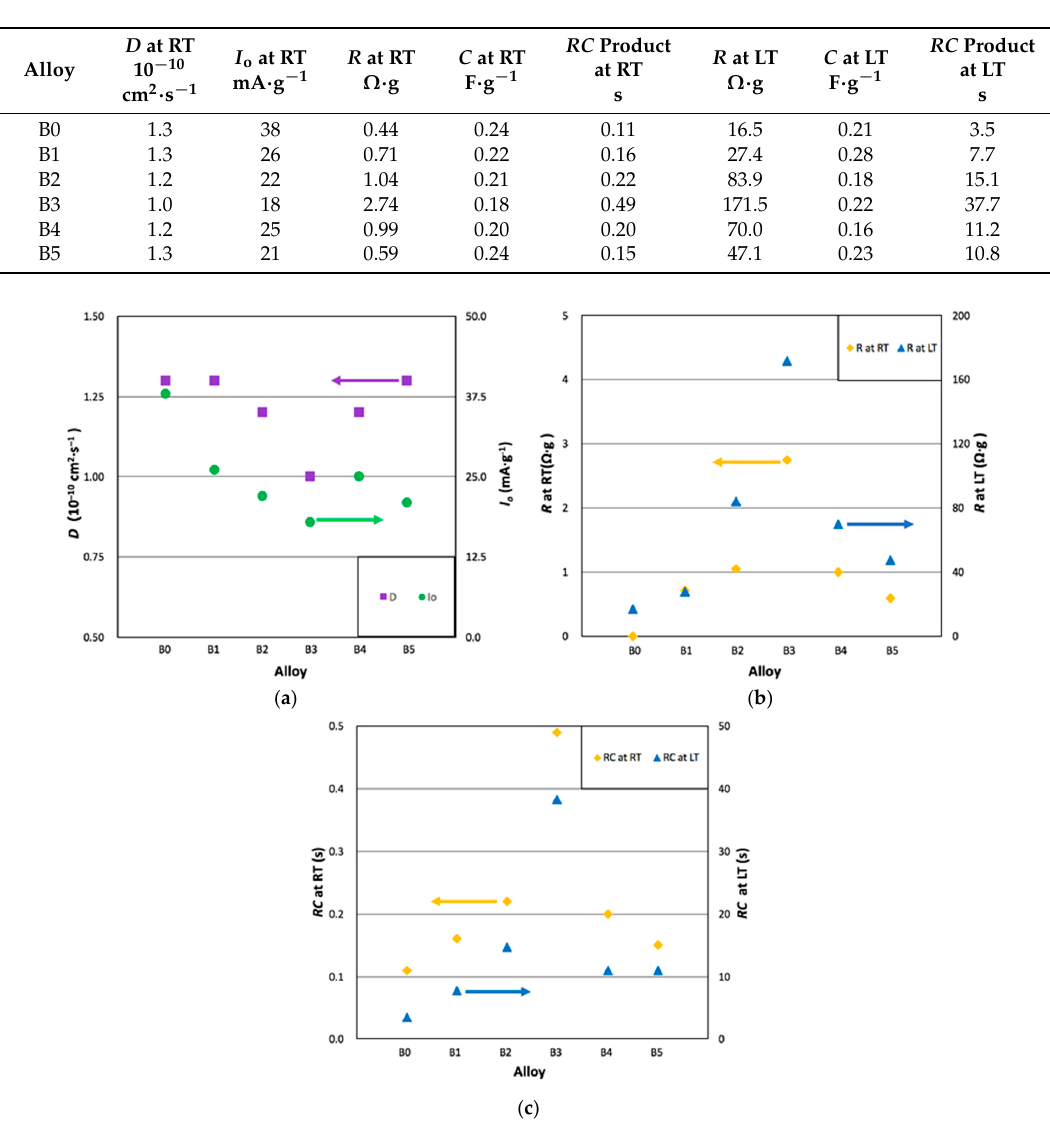
Figure 8. Correlations of ( a ) D and I o vs. alloy number, ( b ) R at RT and LT vs. alloy number, and ( c ) RC at RT and LT vs. alloy number.